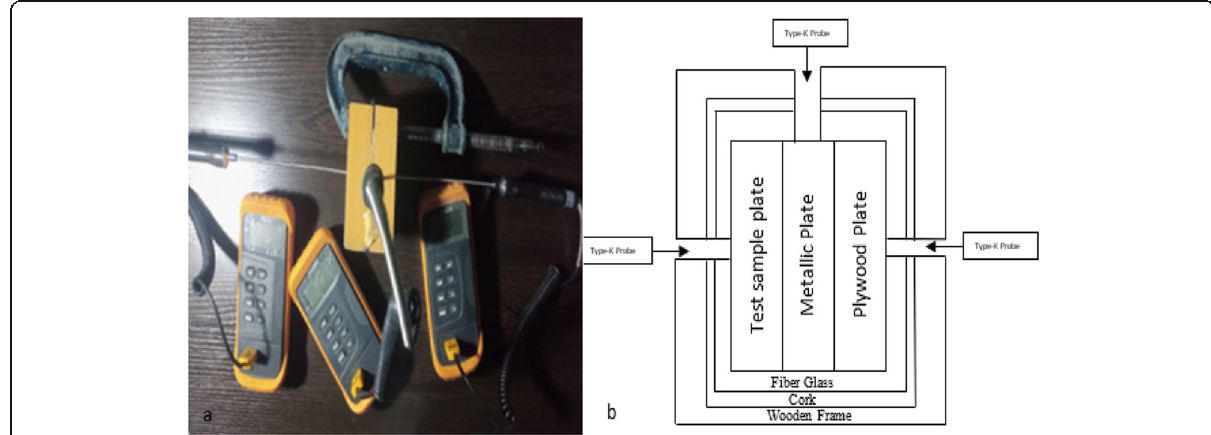
Fig. 2 a View of the SEUR ’ s apparatus in use. b Schematic representation of measurement